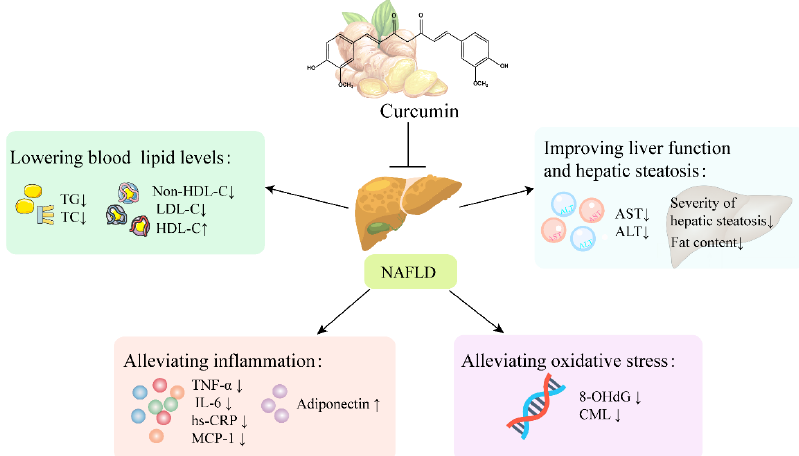
Figure 4. The therapeutic effects and potential mechanisms of curcumin on NAFLD. ↑ indicates increase and ↓ indicates decrease. Specifically, curcumin can improve liver function and hepatic steatosis and lower blood lipid levels. Moreover, curcumin alleviates inflammation by decreasing the levels of IL-6, TNF- α, hs-CRP and MCP-1, and increasing the anti-inflammatory cytokine adiponectin. Curcumin alleviates oxidative stress by decreasing the expression of 8-OHdG and CML.